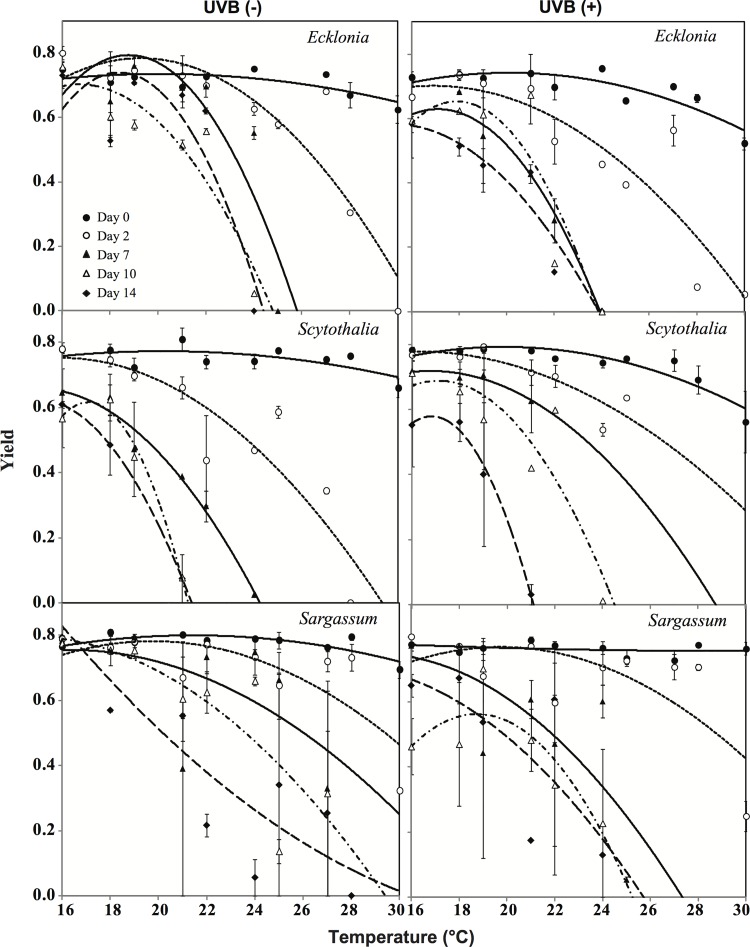
Maximum quantum yield values (mean ± standard error) measured on dark-adapted Ecklonia, Scytothalia and Sargassum, after 0, 2, 7, 10 and 14 days of cultivation at temperatures from 16 to 30°C, left: no UVB radiation; right: exposed to UVB radiation.